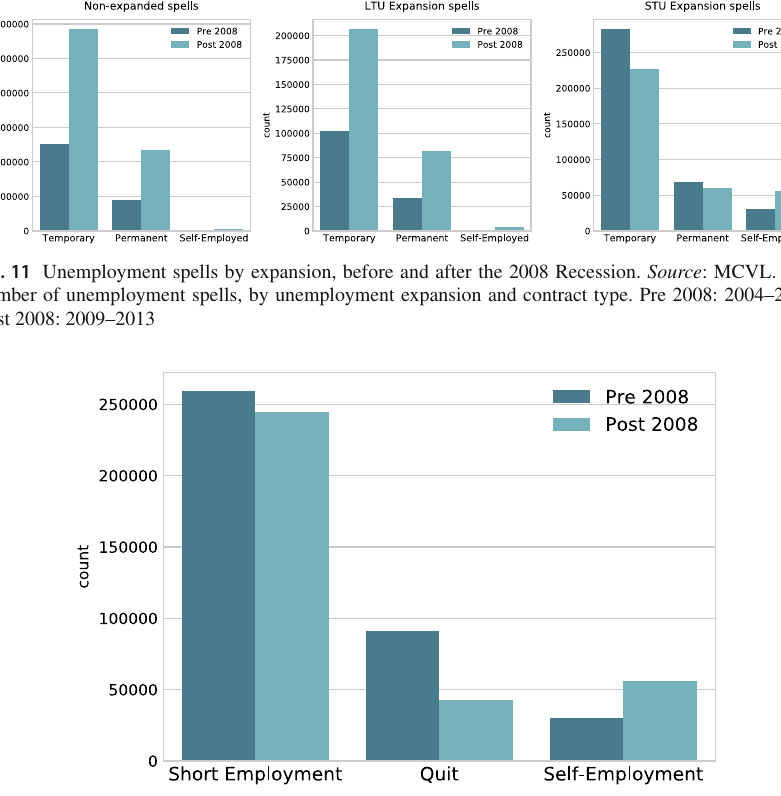
Fig. 12 STU expanded spells by type, before and after the 2008 Recession. Source : MCVL. Raw number unemployment spells affected by the STU expansion, by category. Pre 2008: 2004–2008. Post 2008: